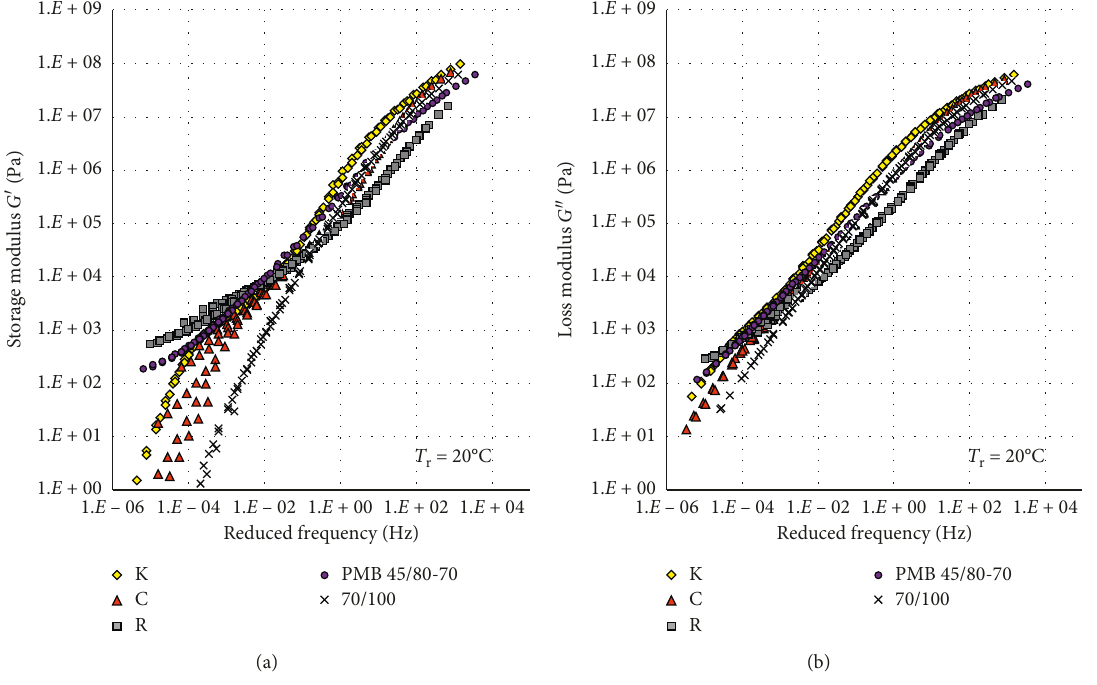
Figure 7: G and G master curves for the selected ′ ″ rubbery plateau, while δ evolves in distinctive branches, master curve | highlighting the presence of different solid-like compo- ∗ G nents. Consequently, the FTSP cannot be valid in that | | frequency range. ∗